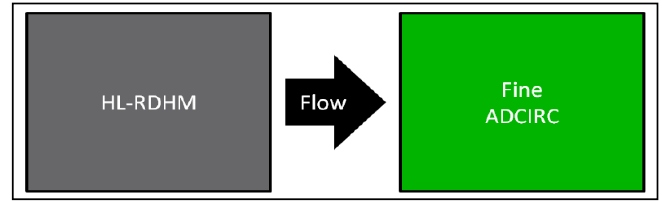
Figure 2. Coupling scheme 1: existing ASGS-STORM